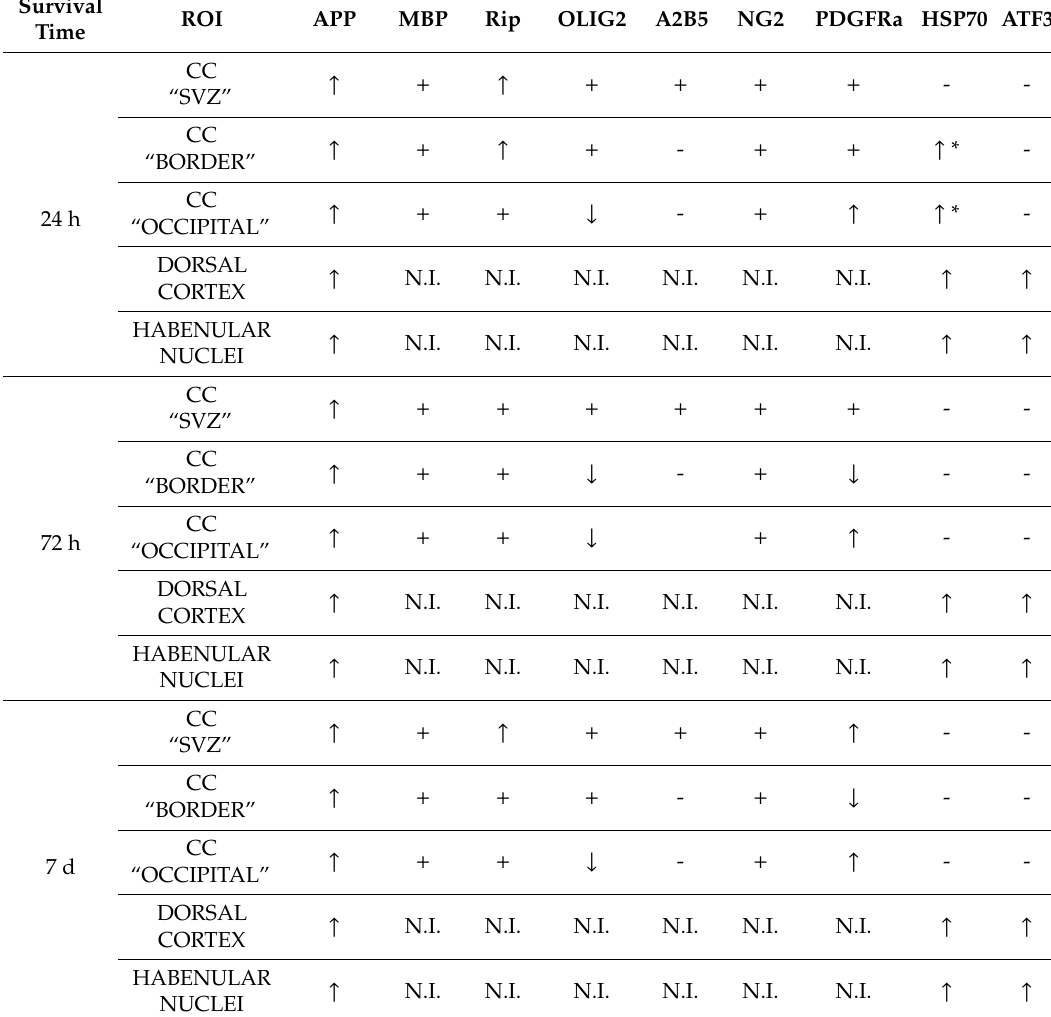
Table 4. Summary of results. Changes in Olig2 and PDGFRa are not statistically significant. + refers to expression of the antibody at similar levels as the sham; - refers to no expression of the antibody, similarly to sham; ↑ refers to increased expression of the antibody, as compared to sham; ↓ refers to decreased expression of the antibody, as compared to sham; N.I. means that the ROI was not investigated for that specific antibody. * changes observed in only one